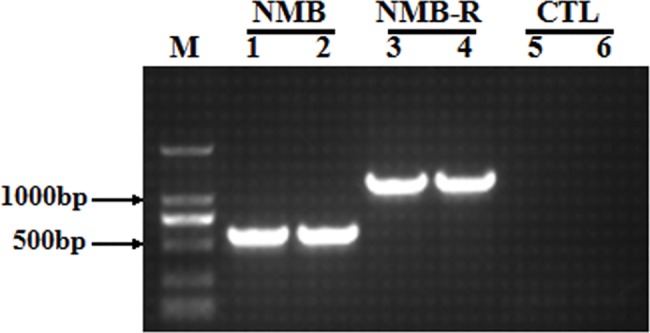
Gel electrophoresis of pig NMB and NMBR PCR products.Lane 1, 2: NMB; Lane 3, 4: NMBR; M: DNA Marker DL 2000; Lane 5, 6: negative control obtained without the addition of cDNA.